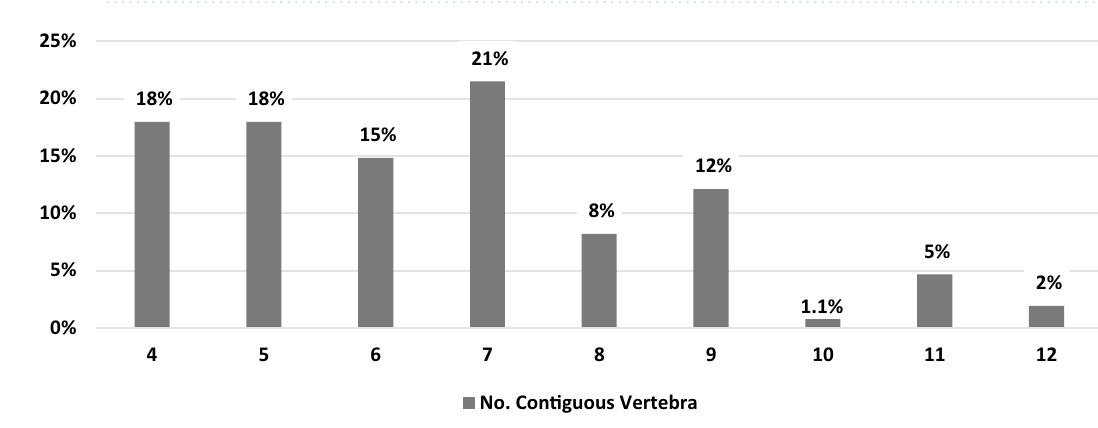
Figure 3. Distribution of the thoracic diffuse idiopathic skeletal hyperostosis based on the spinal segment.